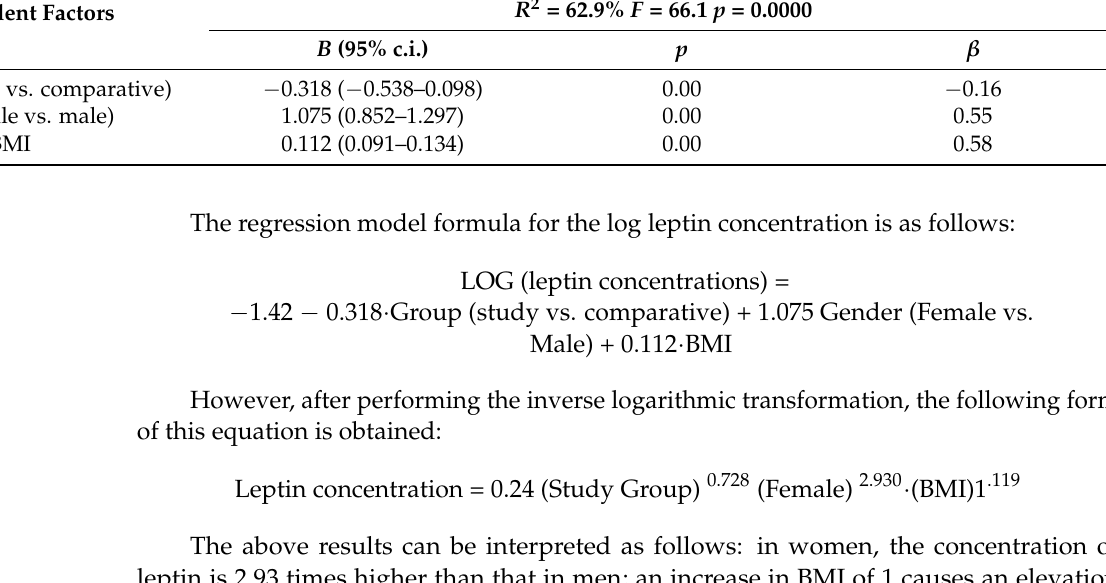
Table 6. LOG leptin concentration in the study (N = 61) and comparison groups ( n = 60). LOG Leptin Concentrations R 2 = 62.9% F = 66.1 p = 0.0000 Independent Factors B (95% c.i.) p β Group (studied vs. comparative) − 0.16 Sex (female vs.